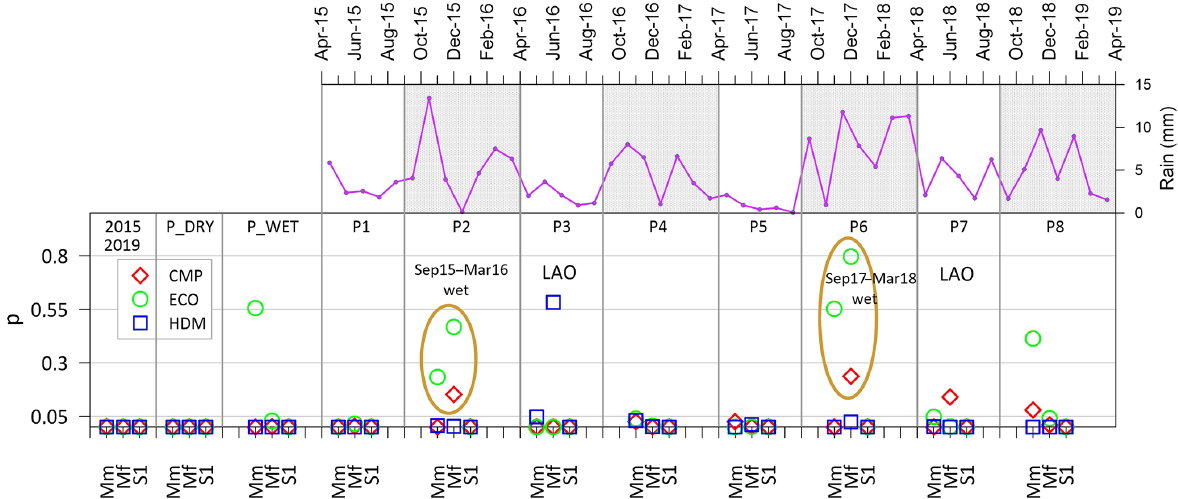
Figure 4. Probability ( p ) values obtained from the Rayleigh test performed on the azimuthal distributions for the three tiltmeters. p -values lower than 0.05 corresponds to non-uniform distribution, while p -values greater than 0.05 support the hypothesis of uniformity. The different time intervals and tidal constituents are indicated on the top and bottom x axes, respectively. The LAO occurrence is also annotated. In the upper panel, the monthly rainfall amount (purple line) is reported (data for Pozzuoli town, available at the URL https://www.3bmeteo.com/ meteo/pozzuoli/storico); in this plot, the light-grey boxes in the background mark the wet season of the hydrological